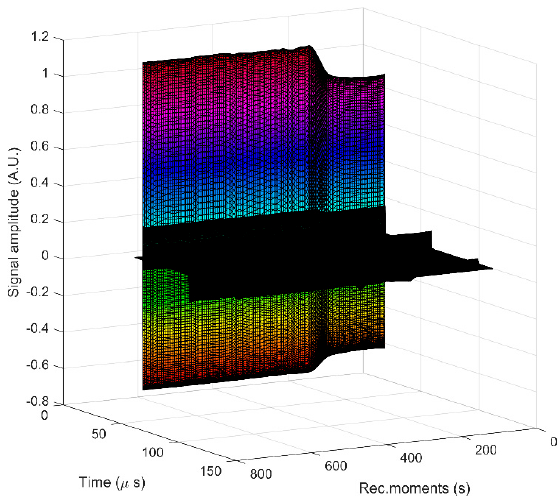
visible in colors, whereas the second and third echo are significantly weaker (in